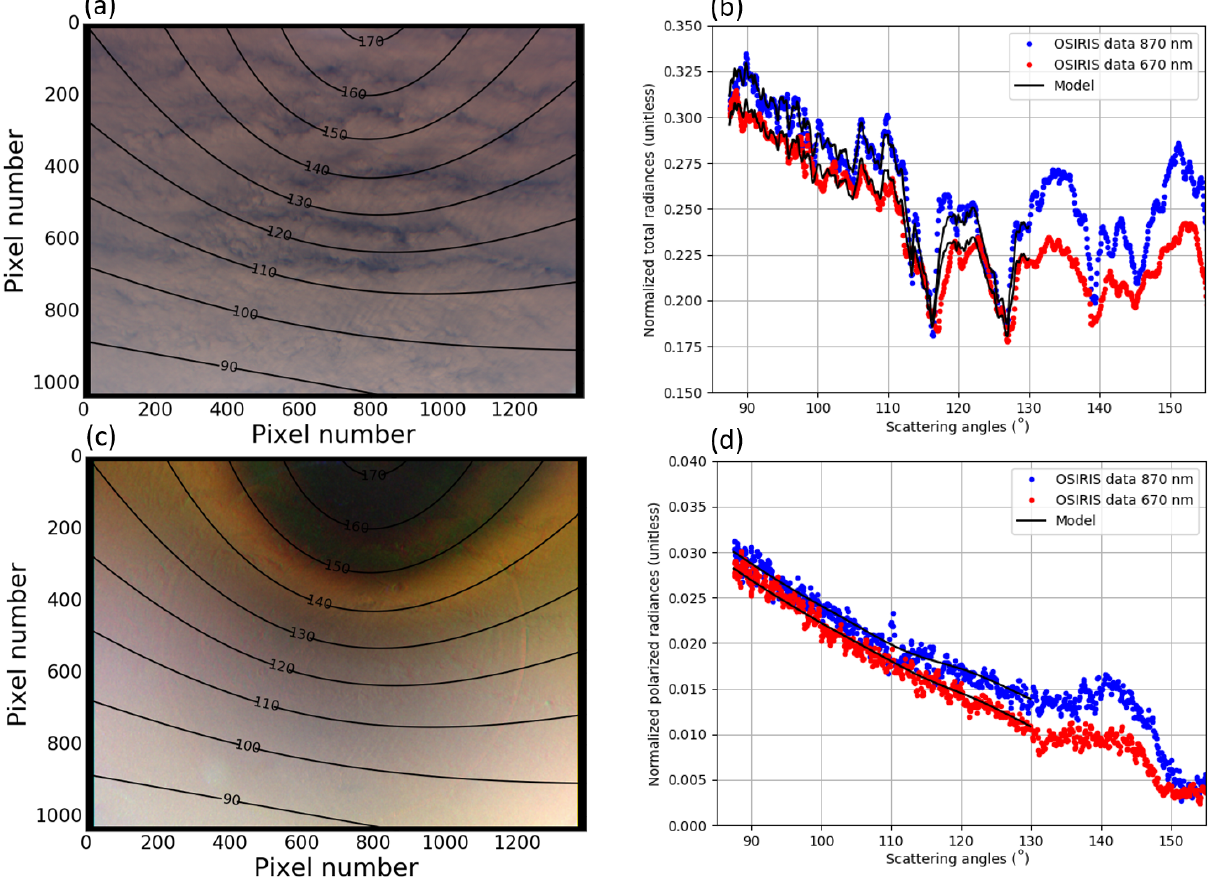
Figure 3. Total and polarized radiances measured by OSIRIS during 8 September 2017. Panels (a) and (c) represent the total, on the top, and the polarized, on the bottom, recomposed RGB radiances for the full OSIRIS image. Panels (b) and (d) represent the corresponding principle planes at 670 (red) and 870nm (blue), respectively. OEM simulations, according Waquet et al. (2013a), of the total and polarized radiances for scattering angles below 130 ◦ are represented with black lines in the panels (b) and (d) . The main aerosol properties retrieved for this case are AOD equal to 0.74 at 670nm, α 490 − 870 = 1 . 82, and SSA equal to 0.87 at